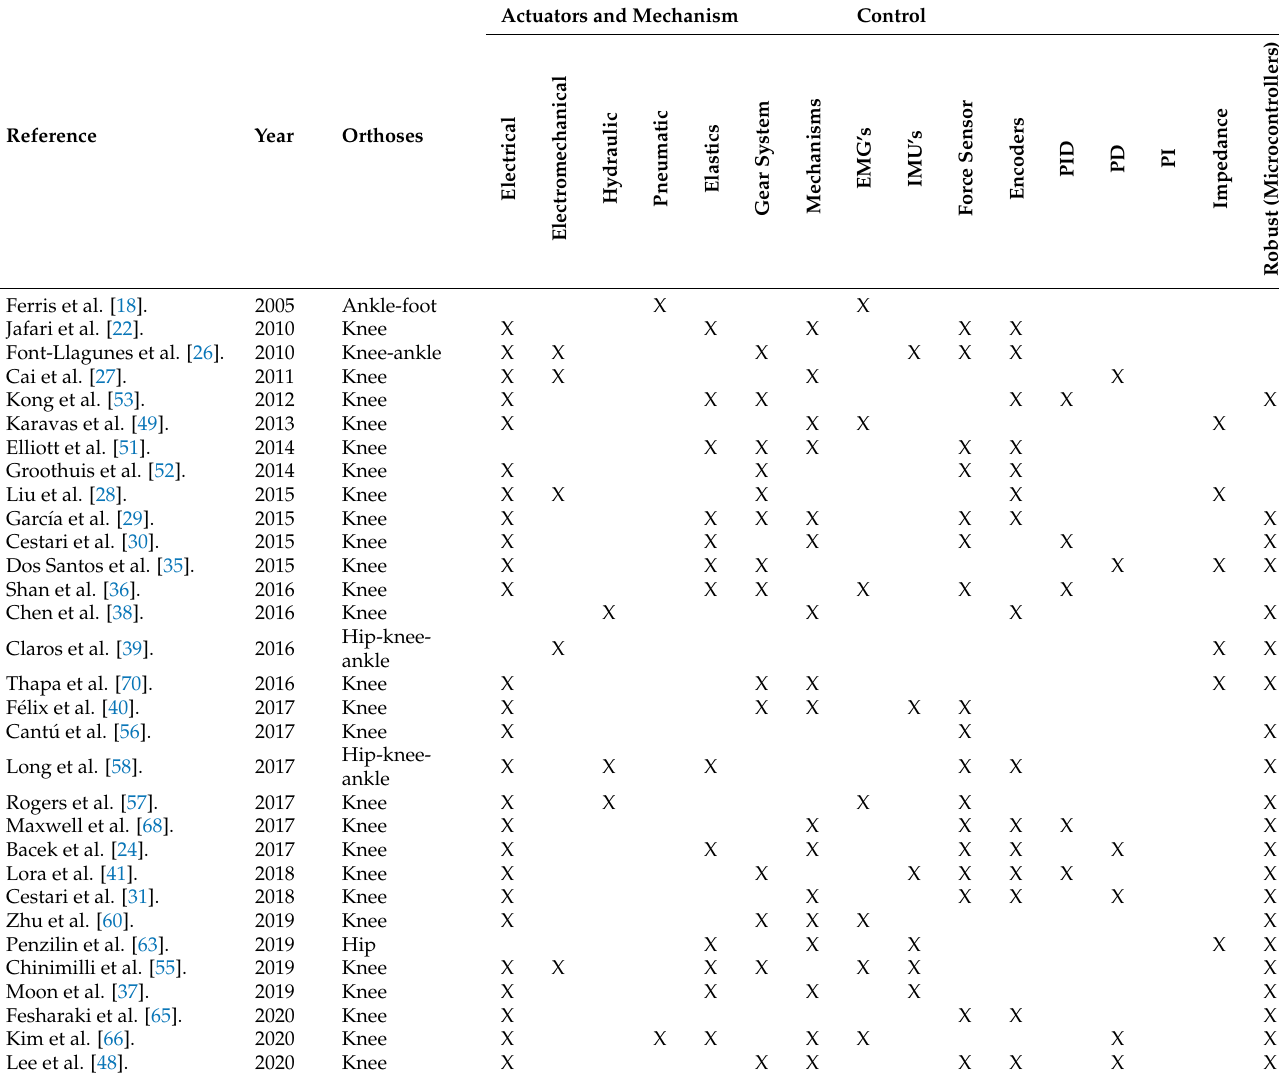
Table 3. Characteristics of active